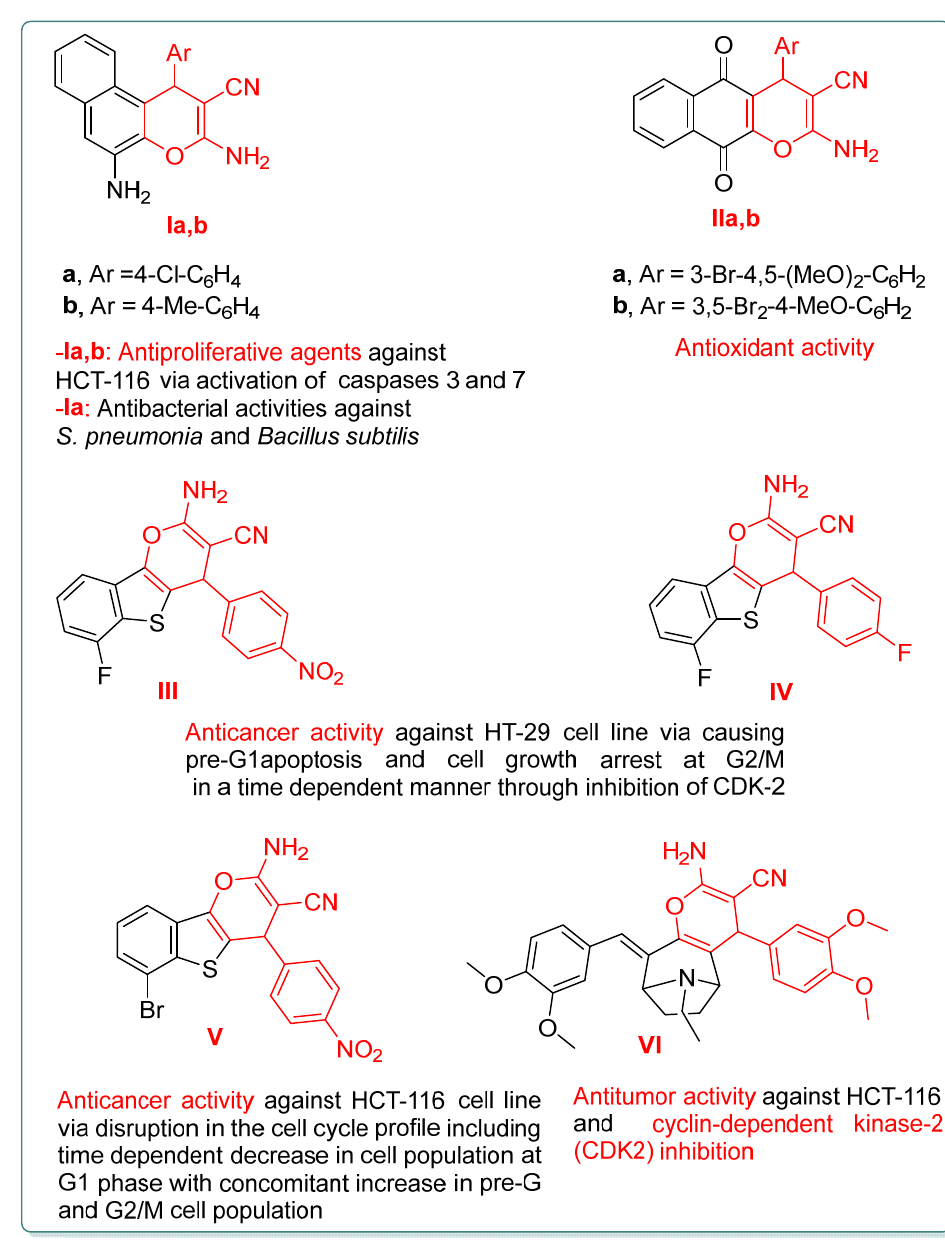
Figure 2. Examples of pyran-containing compounds with antibacterial [33], antioxidant [34] and anticancer activities via inhibition of CDK2 [35–37].